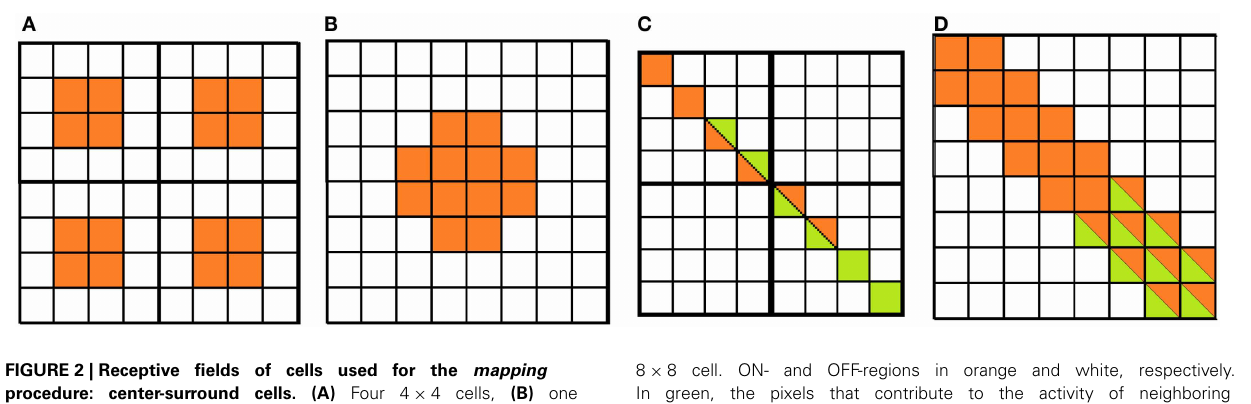
8 × 8 cell. ON- and OFF-regions in orange and white, respectively. In green, the pixels that contribute to the activity of neighboring